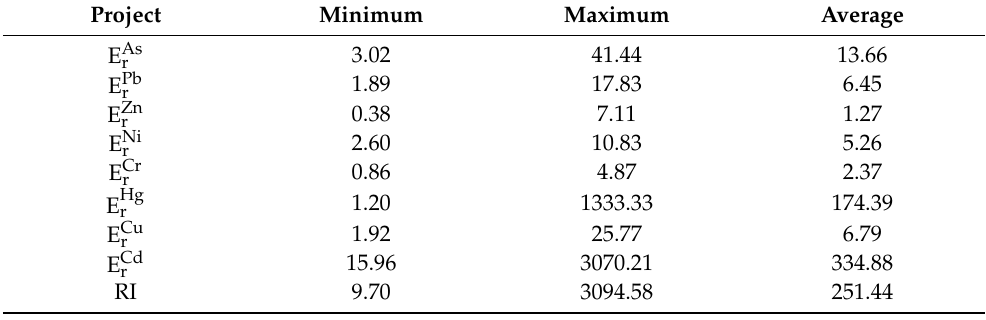
Table 5. Potential ecological risk assessment results of sediments in Weihe River Basin.